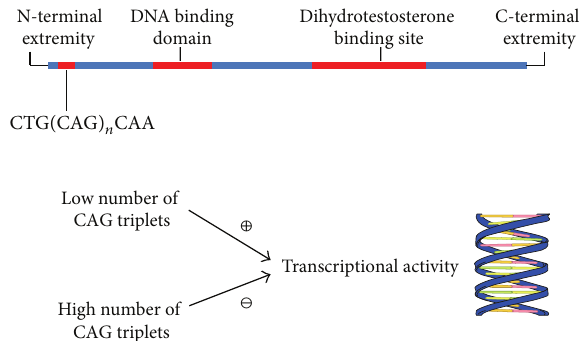
Figure 1: Localization of CAG repeat in androgen receptor and influence on DNA transcriptional activity. Precise mechanisms by which CAG repeat influences DNA trascription are not clear and hypotheses have been raised. Opposite association has been found between CAG repeat (polyglutamine tract) length and DNA trascriptional activity. The polyglutamine tract may indirectly affect androgen receptor function by causing structural perturbations within the transactivation domain. Alternatively, the glutamine res- idues may contact another protein and inhibit interactions of the activation domain with its target protein. Finally, glutamine residues could interact with a specific repressing protein, thus determining inhibition